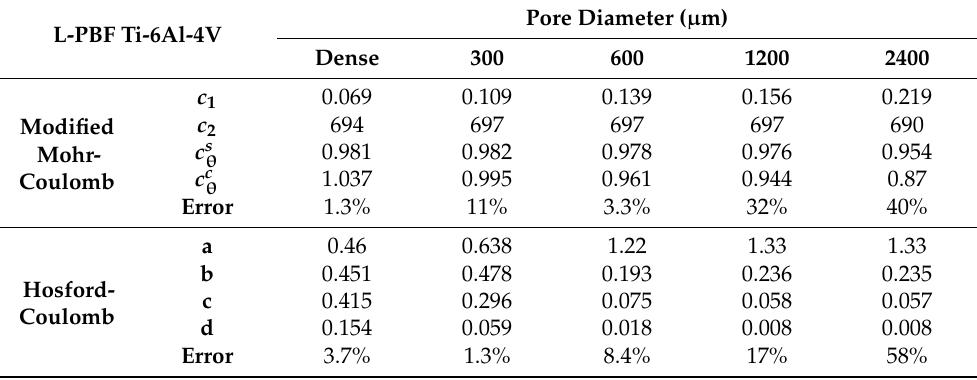
Figure 3. Damage accumulation at fracture for ( a , b ) 316L and ( c , d ) Ti-6Al-4V using the calibrated ( a , c ) modified Mohr- Coulomb and ( b , d ) Hosford-Coulomb models. The dashed line at a value of damage equal to one represents perfect agreement between the model and the experimental/simulation data for each test. Numbers on the horizontal axes denote the pore diameter at the center of the samples. Table 4. Calibrated strain-based ductile fracture model parameters for Ti-6Al-4V using data from and 2400 µ m pore round notched tension tests. Error is mean absolute percentage error for the represents perfect model agreement with